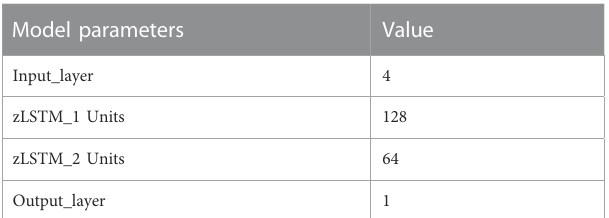
TABLE 3 Parameters of zLSTM Model. Model